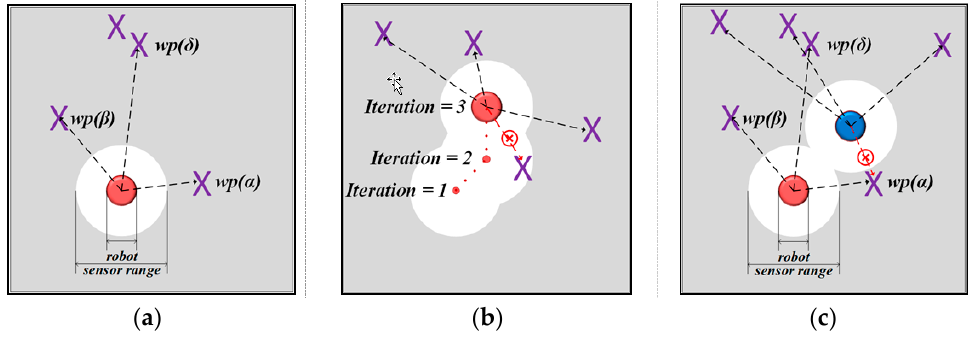
Figure 5. MOGWO exploration: ( a ) selection of the closest waypoints wp α , wp β , wp γ among wp w ; ( b ) the waypoints that are located in the explored space have the lowest probability to be selected by the robot than waypoints in unknown space; ( c ) the best waypoints for one robots should not be duplicated for another robot.